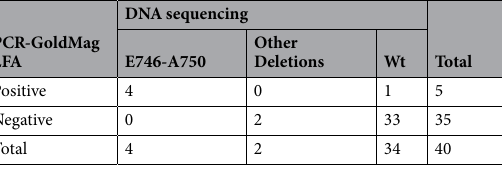
Table 2. Genotyping for E746-A750 by PCR-GoldMag LFA and DNA sequencing (n =